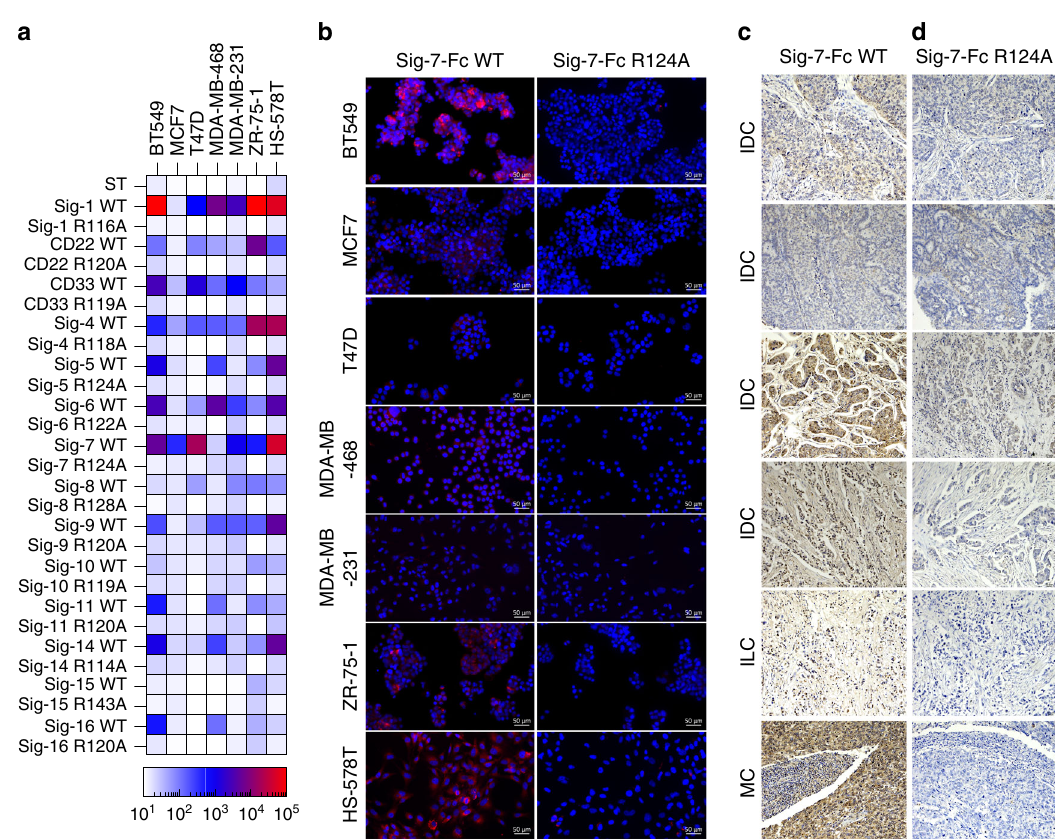
Fig. 4 Siglec ligands on cancer cells and tissues. a Heat map of binding of pre-complexed Siglecs to breast cancer cell lines determined by fl ow cytometry. b Immuno fl uorescence staining of cancer cell lines BT549, MCF-7, T47D, MDA-MB-468, MDA-MB-231, ZR-75-1, and HS-578T with Siglec-7-Fc WT and R124A. Immuno fl uorescence results on breast cancer cell lines are representative of three independent replicates. c , d Breast cancer patient tissue cores with a pathology diagnosis of IDC (invasive ductal carcinoma), ILC (invasive lobular carcinoma) and MC (medullary carcinoma) were immunostained with: Siglec-7-Fc WT ( c ), Siglec-7-Fc R124A ( d ) and imaged at ×20 magni fi cation. Positive signal is represented by brown coloration from chromogenic staining. Darker staining as represented by increased brown coloration indicates Siglec-7-Fc binding ( c ) as compared to control ( d ), while blue staining represents cell nuclei (hemotaxylin stain). IHC results are representative of two independent replicates. Scale bars are indicated as 20 µ m with a tissue width of 670 µ